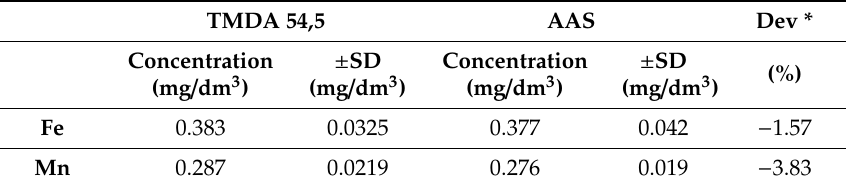
Table 2. Comparison of measured and certified concentrations in TMDA 54,5 (mg / dm 3